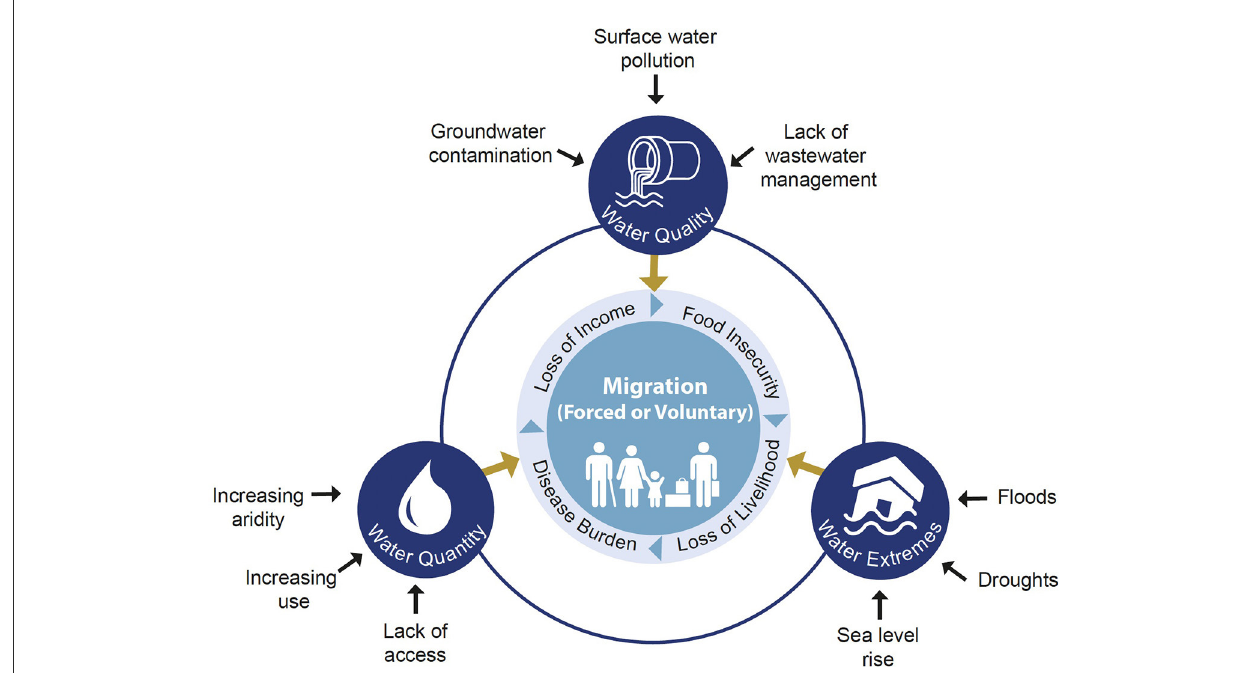
FIGURE1 Three-dimensional framework to assess the water-migration interconnections (Source: Nagabhatla et al.,